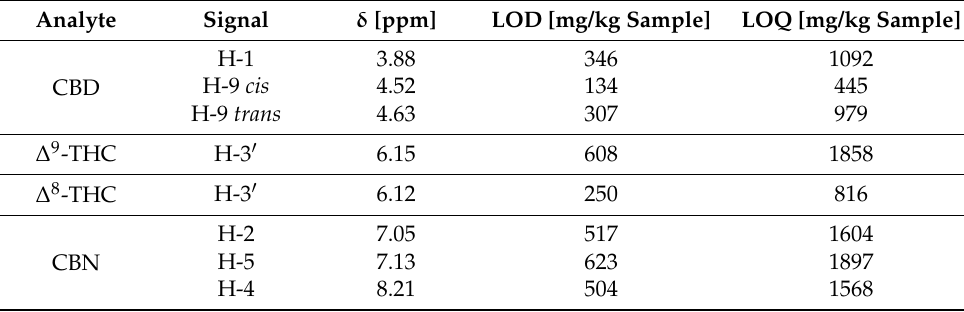
Table 3. LOD and LOQ of the 1 H NMR method for the screening of cannabinoids in CBD